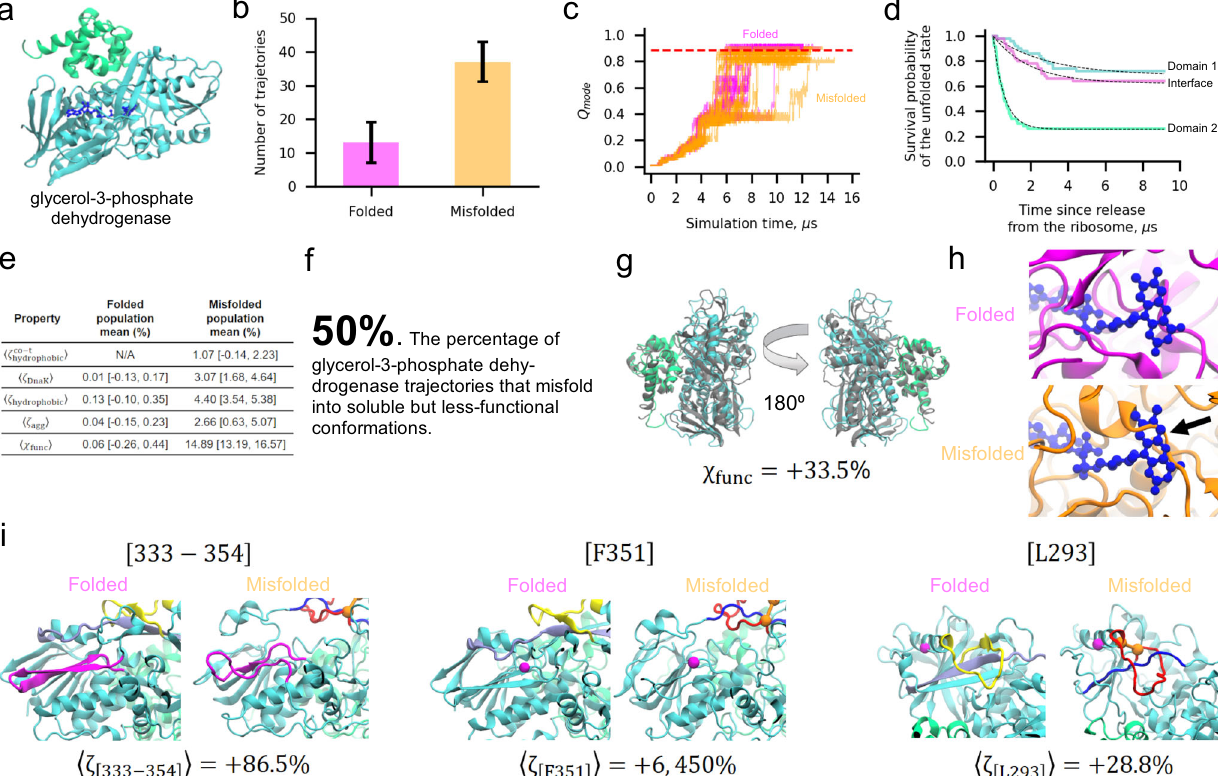
Fig. 5 The two-domain glycerol-3-phosphate dehydrogenase protein displays widespread misfolding into soluble but less-functional conformations. a Ribbon structure of glycerol-3-phosphate dehydrogenase (PDB ID: 2QCU). Domains 1 and 2 are composed of residues 1 – 387 and 388 – 501 and are colored cyan and green, respectively. The FAD cofactor is shown in a dark blue representation. b Number of folded ( N ¼ 13) and misfolded ( N ¼ 37) trajectories for this protein from 50 independent simulations. c Q mode versus time for Domain 1 for the subpopulations of folded (magenta) and misfolded (orange) trajectories. Each line represents one independent trajectory. d Survival probability of the unfolded state versus time computed for Domain 1 (cyan), Domain 2 (green), and the Domain 1|2 interface as described in “ Methods ” . Dotted black lines are double-exponential fi ts. e Key parameters for the folded and misfolded populations. f 50% [36%, 64%] of glycerol-3-phosphate dehydrogenase trajectories are predicted to remain soluble but non- functional. g Representative misfolded structure colored as in ( a ) aligned to the native-state reference structure. Despite a high χ value indicative of a func less-functional conformation, the protein is largely native. h Representative folded and misfolded structures back-mapped to all-atom resolution and then aligned to the native state based on the FAD-binding pocket residues. Steric con fl ict (indicated by black arrow) can be seen between the substrate-binding location and the misfolded binding pocket, indicating reduced function of this conformation. i Three pairs of structures corresponding to the native state (left) and the fi rst representative structure of metastable state S2 (right) with locations of [333 – 354], F351, and L293 indicated in magenta. The loop (residues 271 – 288) and threading (residues 218 – 237) segments of the entanglement present in S2 are shown in red and blue, respectively. The same regions are colored yellow and light purple in the native state for reference, though no entanglement is present. The CA atoms of residues 271 and 288 that form the contact closing the loop segment are represented by orange spheres. Values of h ζ peptide i were calculated with Eq. (16); error bars are available in Supplementary Table 8. All error bars are 95% con fi dence intervals computed from bootstrapping 10 6